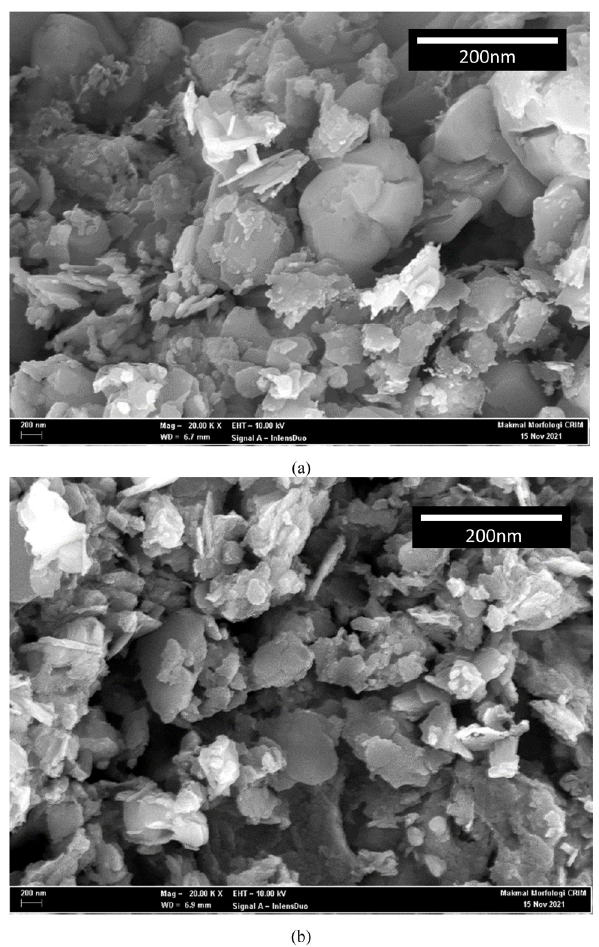
Figure 5: FESEM images of ( a ) CaAl LDH and ( b ) CaAl - MCPA at 20,000 × magni fi